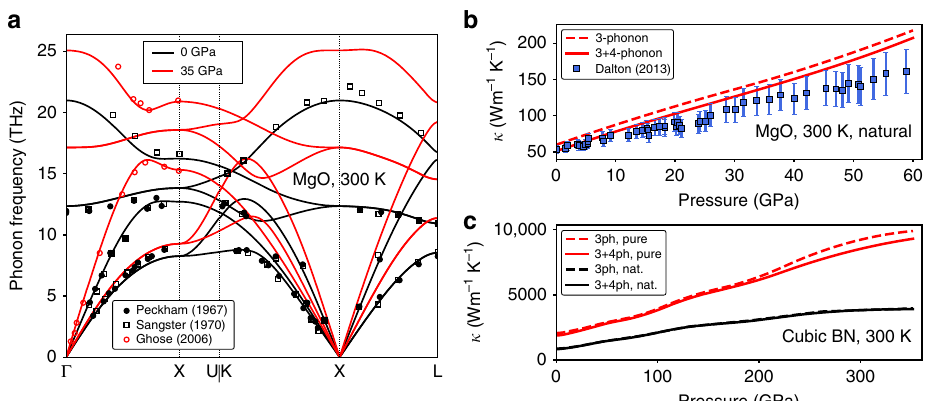
Fig. 1 Phonons and thermal conductivity of MgO and cBN under pressure. a Phonon dispersions for MgO at 300 K computed at 0 GPa (black) and 35 GPa (red) pressures. The calculations are in good agreement with the measurements of phonon frequencies at 0 GPa 32,33 and 35 GPa 34 . b Three-phonon and 3 + 4-phonon limited κ of MgO versus pressure at 300 K compared with experiments 9 . c Three-phonon and 3 + 4-phonon limited κ of cBN (red curves: isotopically pure 11 B 14 N, black curves: naturally occurring cBN) versus pressure at 300 K. Our results for cBN differ from those in ref. 46 , where a bimodal behavior of the three-phonon limited κ for cBN with increasing pressure was observed, but was later identi fi ed 18 to be erroneous and related to required symmetries of the inter-atomic force constants used in ref. 46 not being satis fi